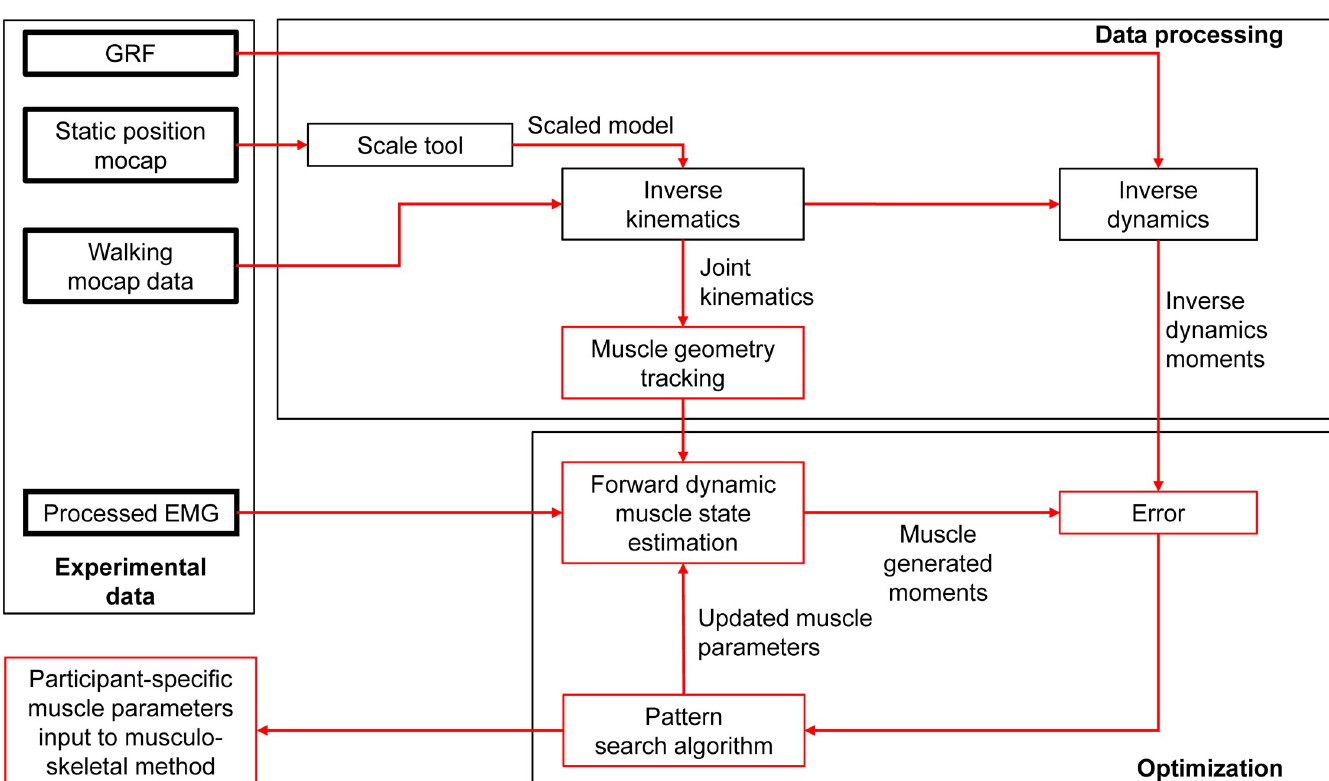
Fig 4. Processing methods. Flowchart describing the steps that were used to process the recorded data for the inverse kinematics, inverse dynamics, and forward dynamics muscle state estimation. The default muscle parameters from the scaling step (tendon slack length and optimal fiber length) were optimized with a generalized pattern search algorithm to maximize the agreement with the moments from the inverse dynamics. The optimized muscle parameters were used as inputs for the musculoskeletal simulation that was used for the estimation of metabolic rate with muscle metabolic rate equations. The data from the kinematic and inverse dynamic analyses were used as inputs for the joint-space metabolic rate